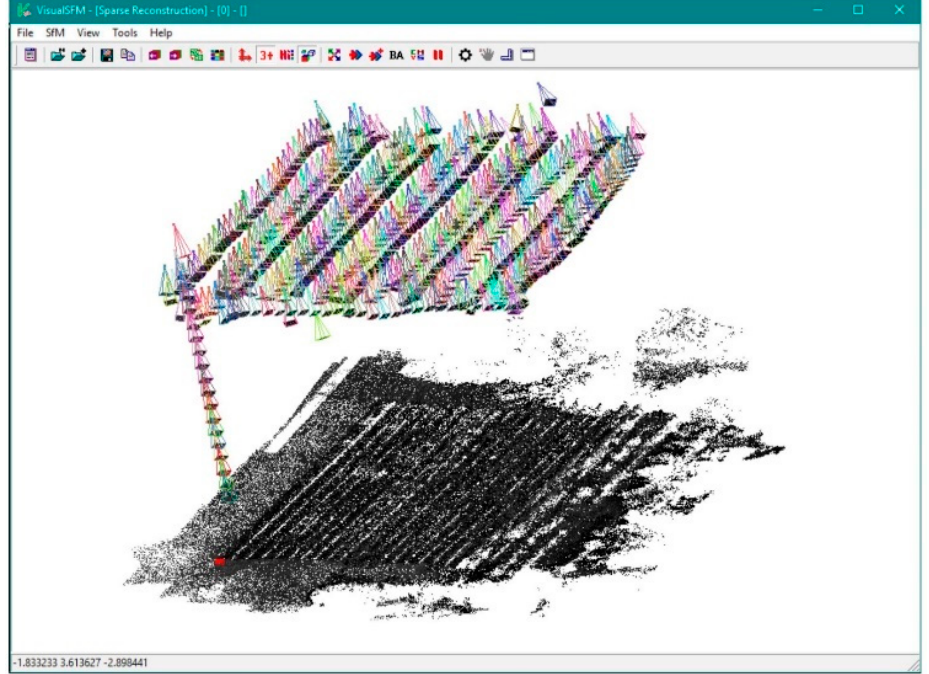
Figure 3. Sparse cloud and cameras of the set relative to the RED W band.